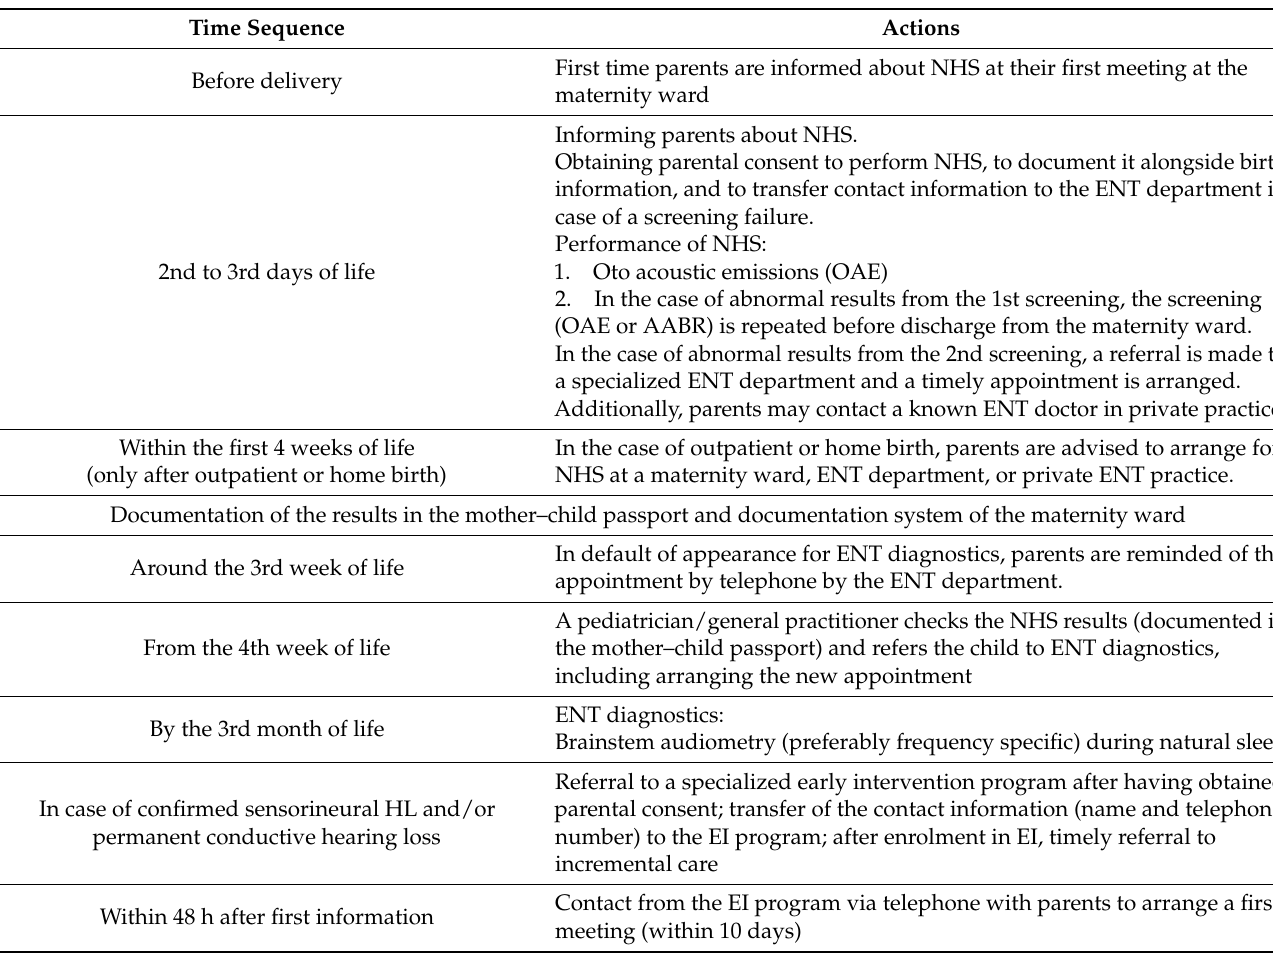
Table 1. NHS and tracking protocol for Upper